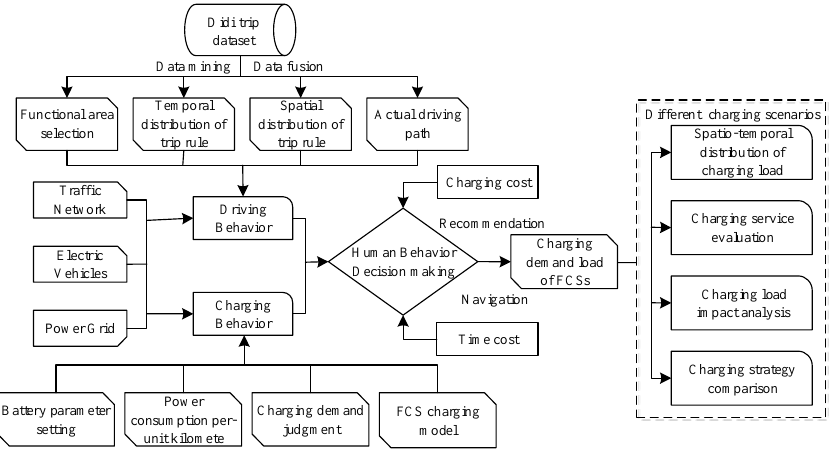
Figure 6. Framework of electric vehicle fast-charging demand prediction model.